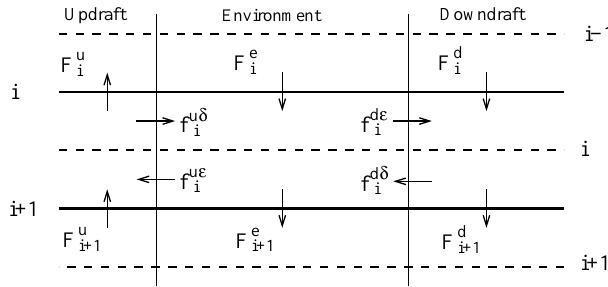
Figure 2. Schematic representation of fluxes involved in the KF scheme. Uppercase F represent the fluxes between vertical levels (across level boundaries) while lowercase f are the fluxes within a level that represent the exchange of mass between environment (e) and updraft (u) or downdraft (d),